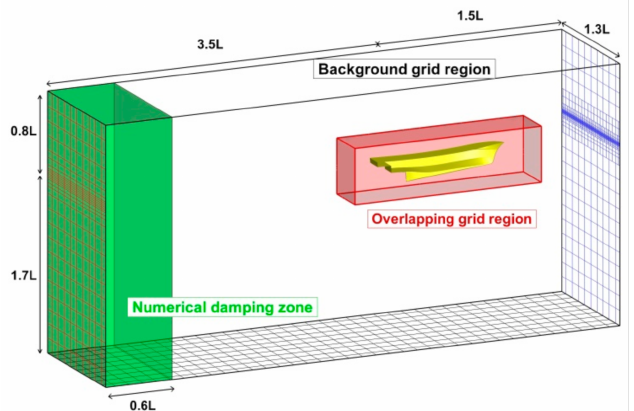
Figure 2. Computational domain and boundary